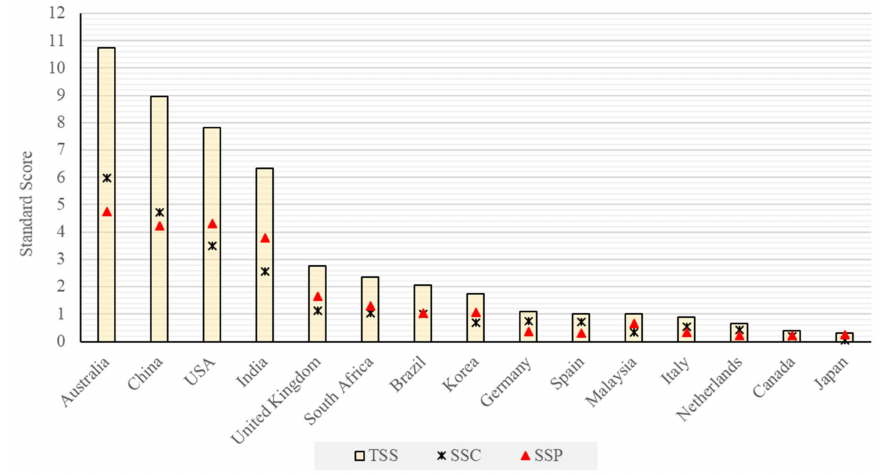
Figure 8. The national academic impact, 1982–2021. SSC is the standard score of citation, SSP is the standard score of publications and TSS is the total standard score.